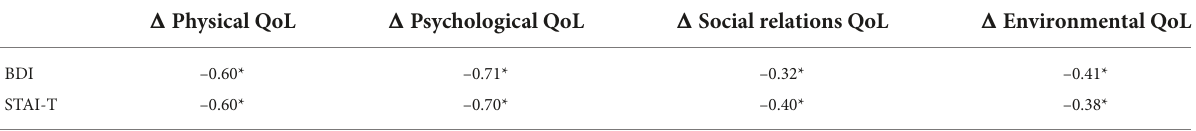
TABLE 5 Correlations between changes in depressive ( (cid:49) BDI) and anxious symptoms ( (cid:49) STAI-T) and changes in different subdomains of quality of life ( (cid:49) QoL) correlation coefficients are displayed. (cid:49) Physical QoL